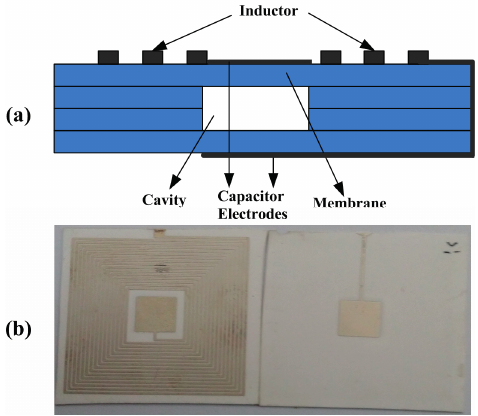
Figure 7. ( a ) Sectional view of the sensor based on alumina ceramic substrate; ( b ) Sensor sample.